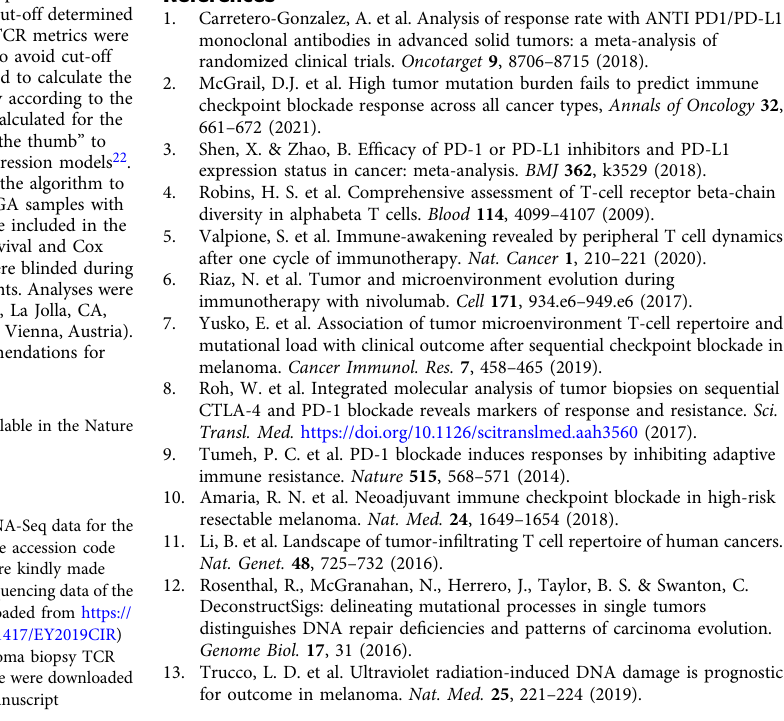
Fig. 3 TIL/Tc TCR diversity is prognostic across several cancer histotypes. A – L Analyses of the TCGA cancer cohorts. A Estimated total number of tumor-in fi ltrating T cells (TIL/Tc) in the cancer cohorts; the cohorts above the upper quartile of TIL/Tc are highlighted in blue; B – G survival curves for the cancer cohorts with abundant TIL/Tc from A of patients with high (blue) or low (pink) TIL diversity: B BRCA ( n = 908, cut-off = 3.34, OS log-rank P = 0.0029), C LUSC patients with cigarette use < median ( n = 238, cut-off = 3.17, OS log-rank P = 0.2849), D LUAD ( n = 481, cut-off = 3.53, OS log-rank P = 0.0204), E TGCT ( n = 148, cut-off = 3.29, DFI log-rank P = 0.0124), F KIRK ( n = 322, cut-off = 3.26, OS log-rank P = 0.0088), G THYM ( n = 92, cut- off = 5.93, OS log-rank P = 0.0306); H – L forest plots showing the HR and 95% CI for the signi fi cant covariates retained in the multivariate Cox regression prognostic model calculated using the fast-backward method and the Akaike Information Criterion as a stopping rule for the cancer cohorts with abundant TIL/Tc from A; TIL/Tc metrics were analyzed as continuous variables: H BRCA (events = 113, model for OS global P < 0.001, concordance index = 0.66), I LUSC patients with cigarette use < median (events = 31, model for OS global P = 0.0096, concordance index = 0.69), J LUAD (events = 166, model for OS global P < 0.001, concordance index = 0.63), K TGCT (events = 31, model for PFS P = 0.0637, concordance index = 0.63), L KIRK (events = 53, model for OS global P < 0.001, concordance index = 0.74). Analyses are two-sided and TIL/Tc diversity is retained as continuous variable in the